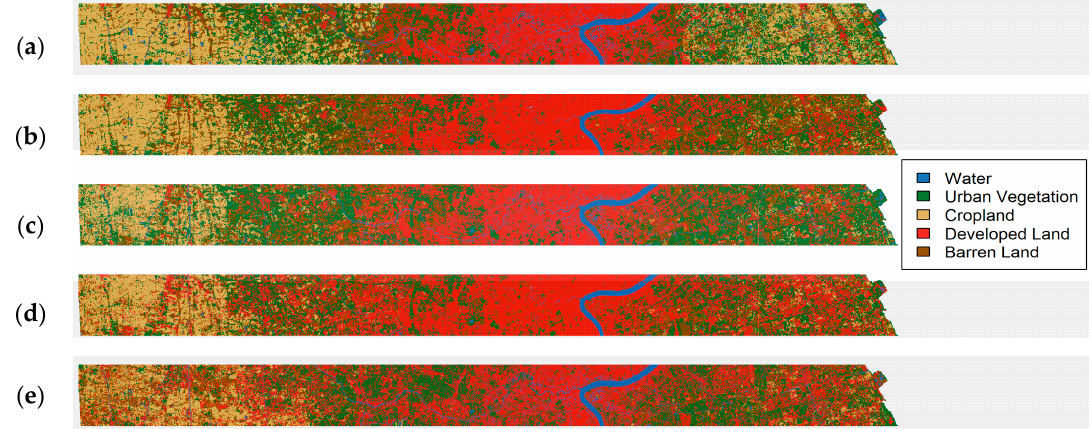
Figure 2. Land-cover/land-use maps including water, urban vegetation, cropland, developed land and barren land for the east-west transect in year ( a ) 1995, ( b ) 2000, ( c ) 2005, ( d ) 2010, and ( e ) 2015 based on Landsat images. Table 4. Percentages of LCLU types generated by AASG within the east-west transect.